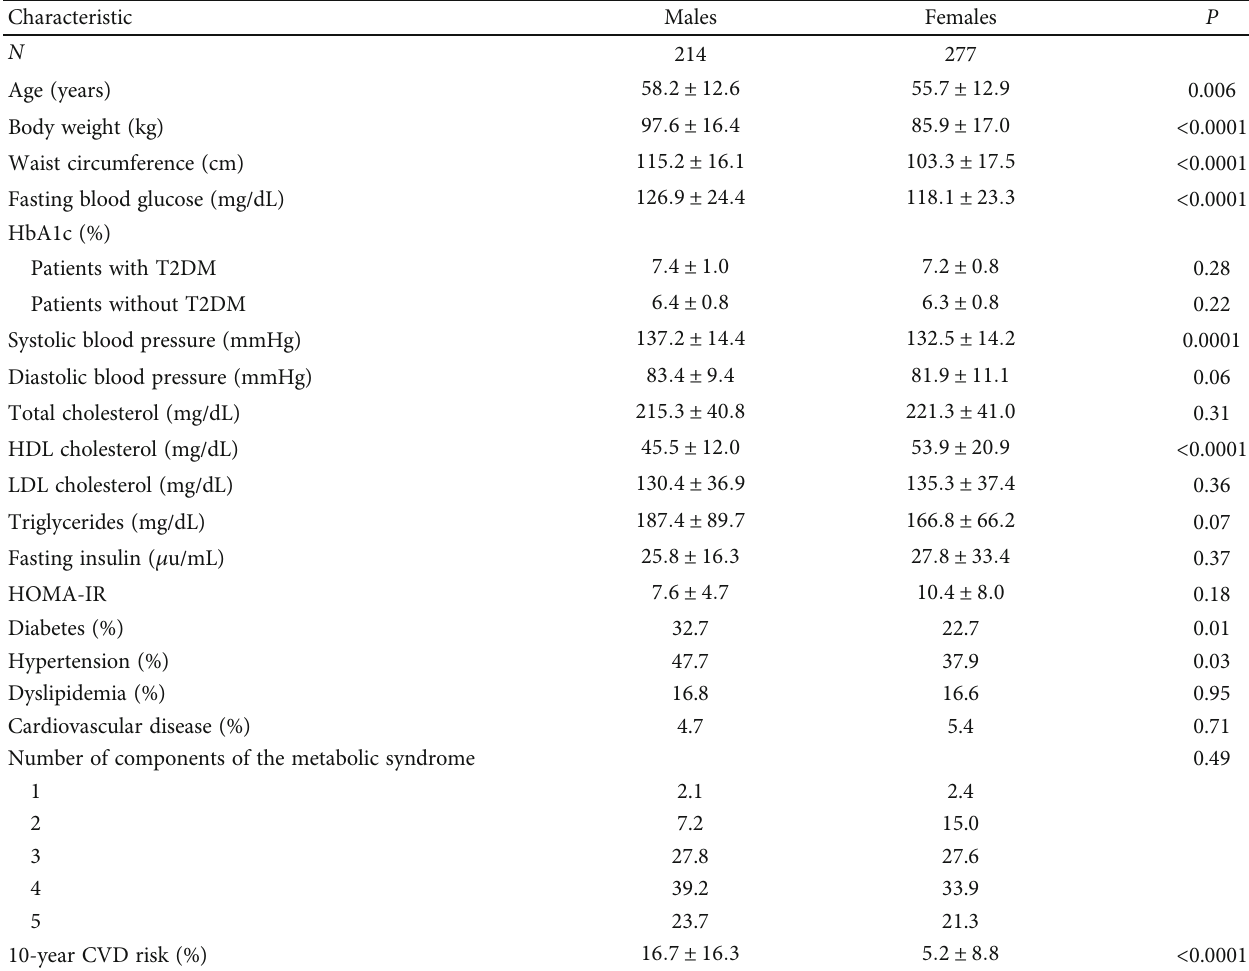
Table 1: Patient characteristics by gender (data are mean ± SD or